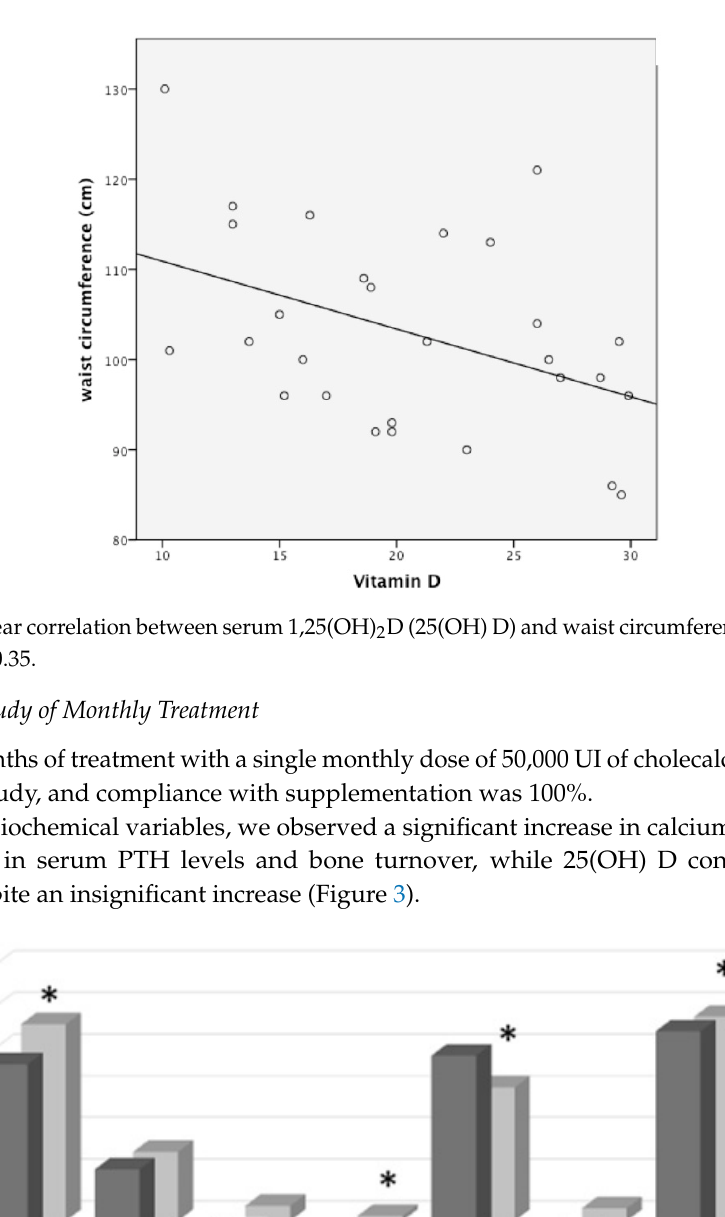
Figure 2. Linear correlation between serum 1,25(OH) 2 D (25(OH) D) and waist circumference at baseline; p < 0.05; R = 0.35.